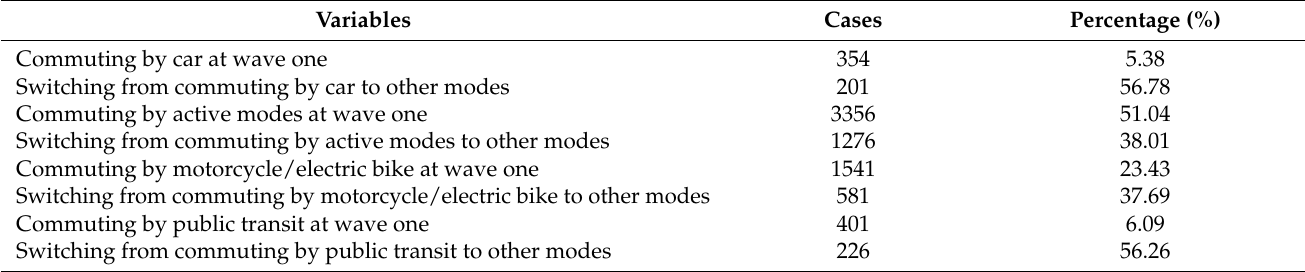
Table 1. Commuting modes and their changes between two